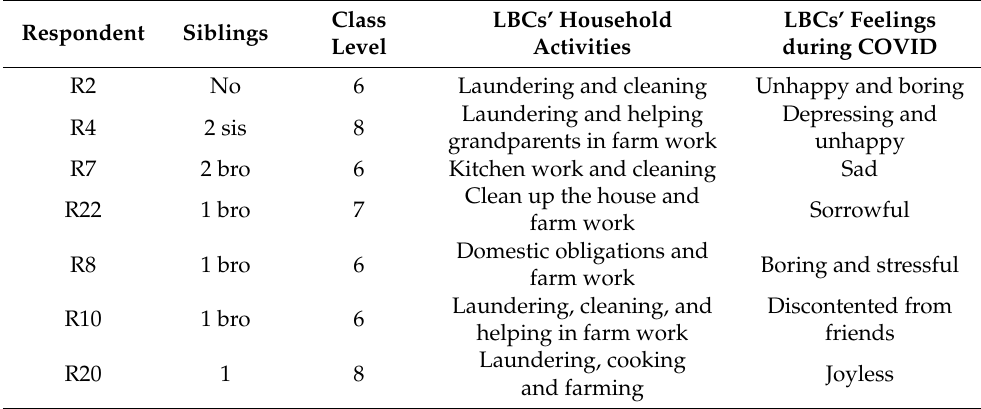
Table 2. LBCs’ view of